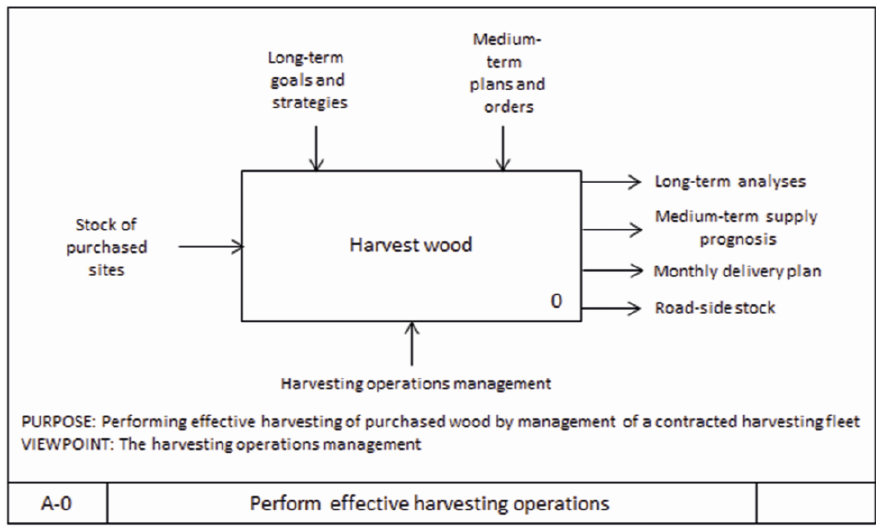
Figure 3. The top-level context diagram (A-0) for the